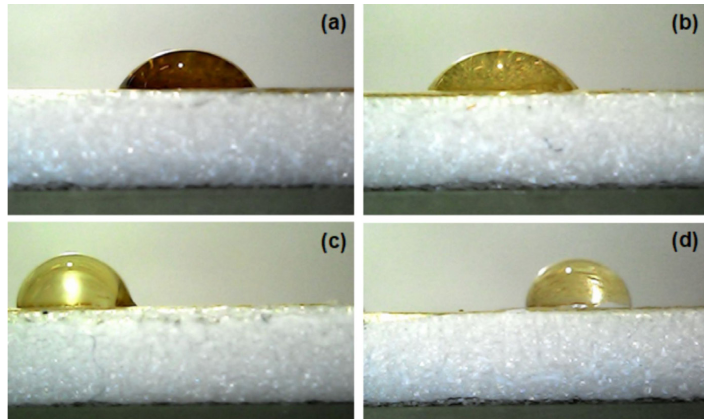
Figure 3. Contact angle of kefir biofilms loaded with Maytenus rigida extract: a) Bio0, b) Bio25, c) Bio50, and d)